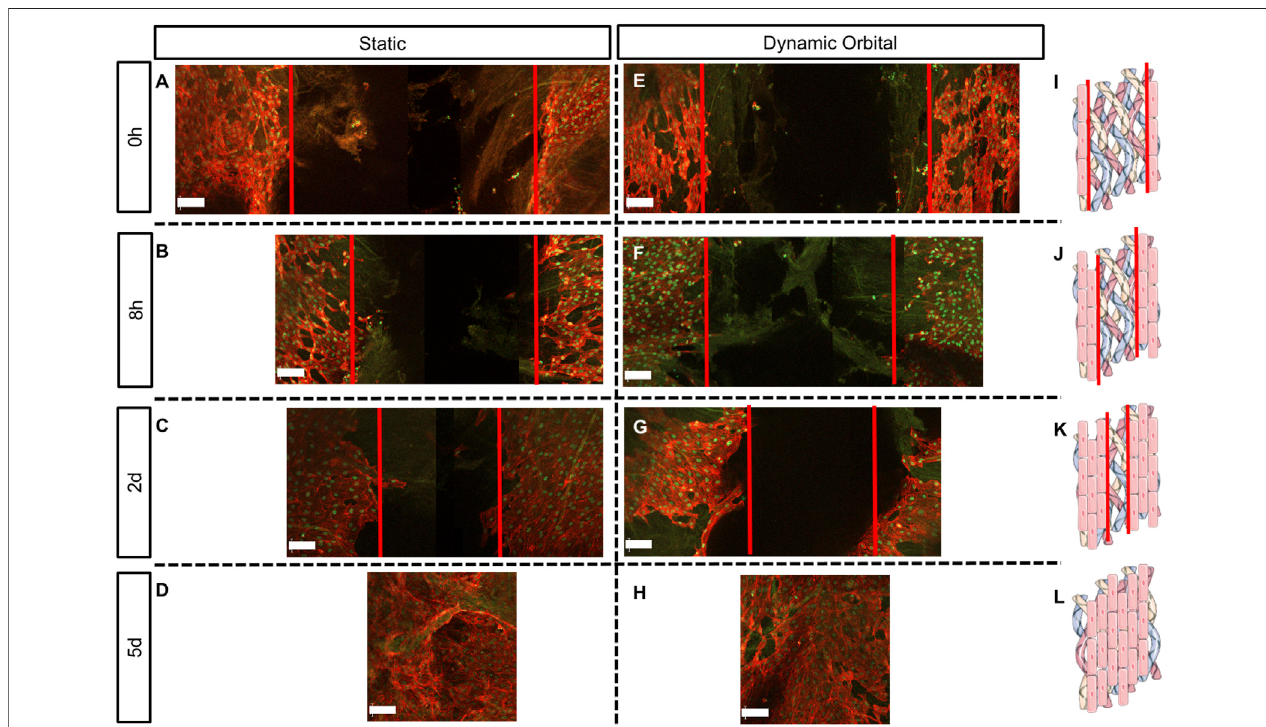
FIGURE 5 | Scratch assay performed on hTEMs seeded with ECFCs and cultured with hPL as medium supplement. Scratch was performed in the middle of the hTEM (red lines). ECFCs were cultured for up to 5 days under static (A – D) or dynamic orbital conditions (E – H) and fi nally stained for Collagen III (green), phalloidin (red) and DAPI (blue). (A,E) : Control scratch performed at time 0, under static and dynamic orbital conditions, respectively. (B,F) : ECFCs migration at 8 h timepoint under static and dynamic orbital conditions, respectively. (C,G) : ECFCs migration at 2 days timepoint under static and dynamic orbital conditions, respectively. (D,H) : ECFCs reached con fl uency after 5 days from scratch. (I – L) : Schematic representation of the scratch assay test on hTEMs (Images adapted from Servier Medical Art under a creative common attribution 3.0 unported license) (500 µm scale bars).